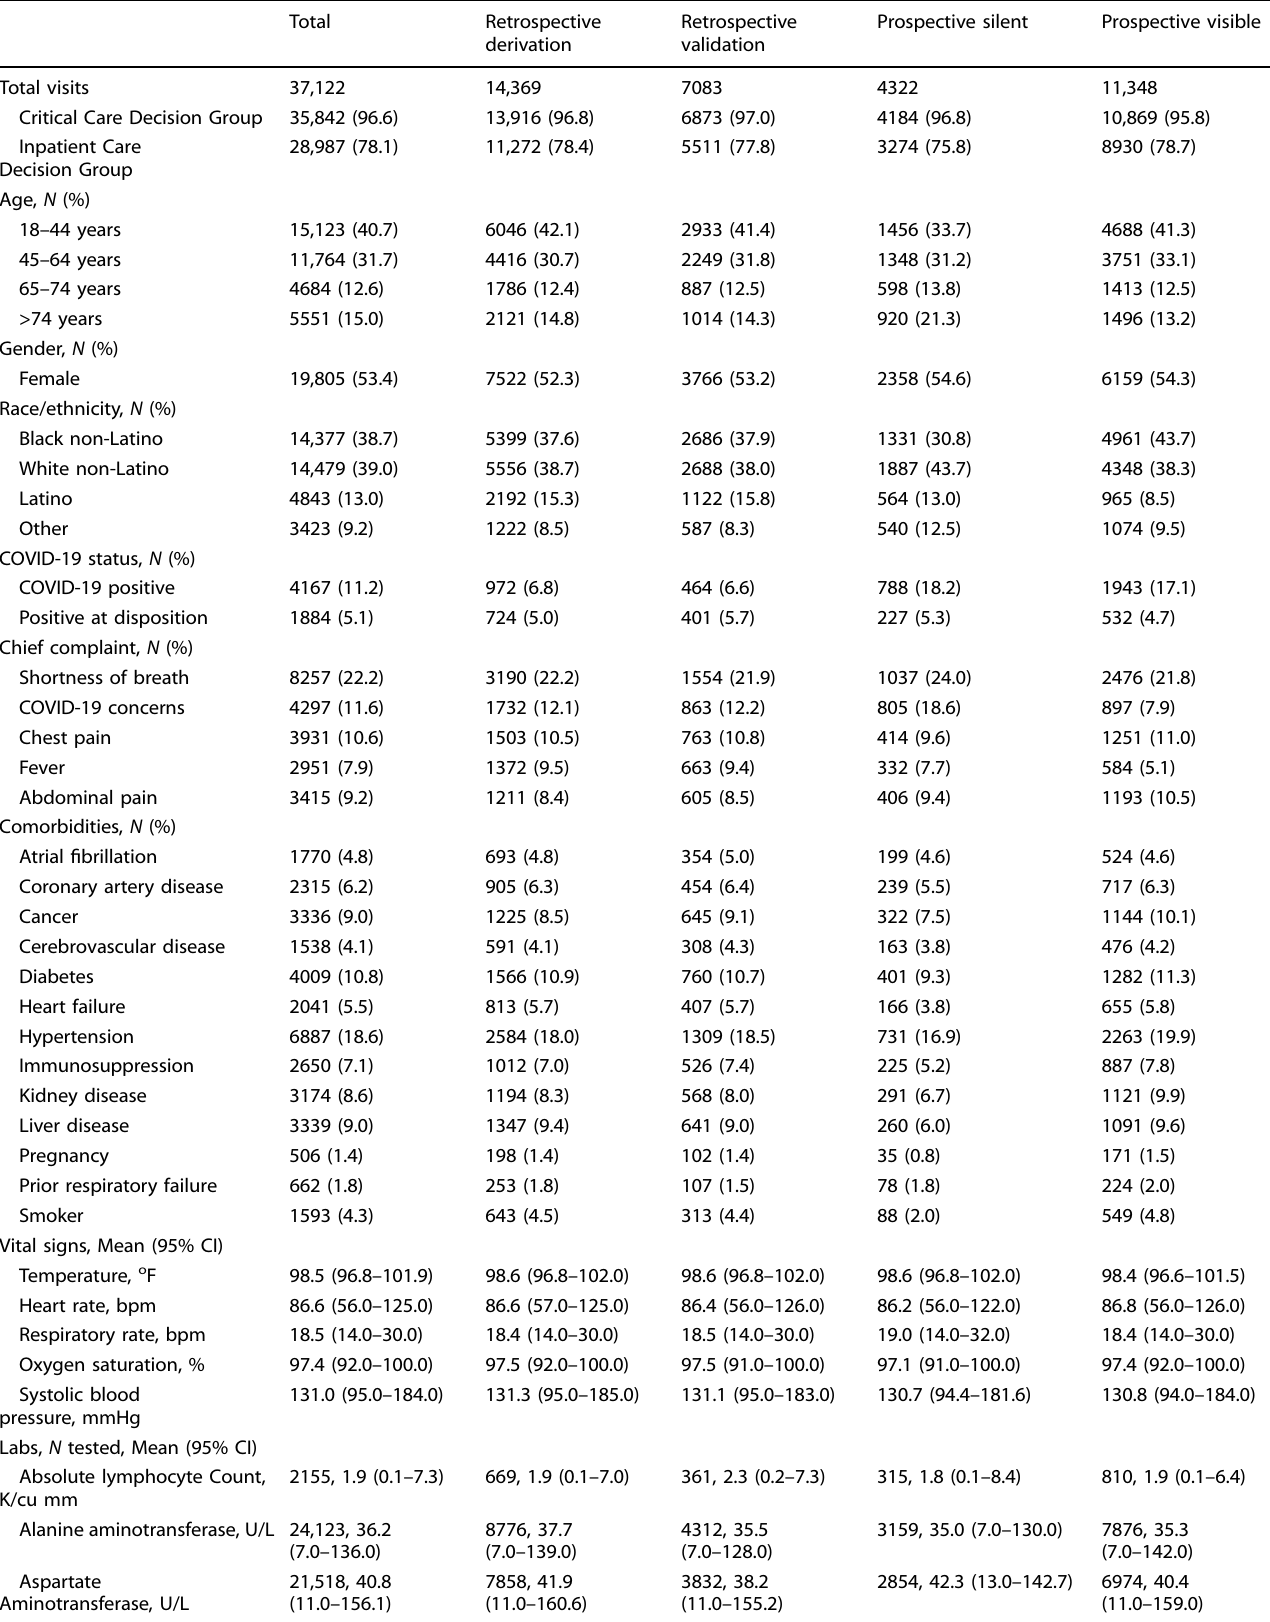
Table 1. Study cohort